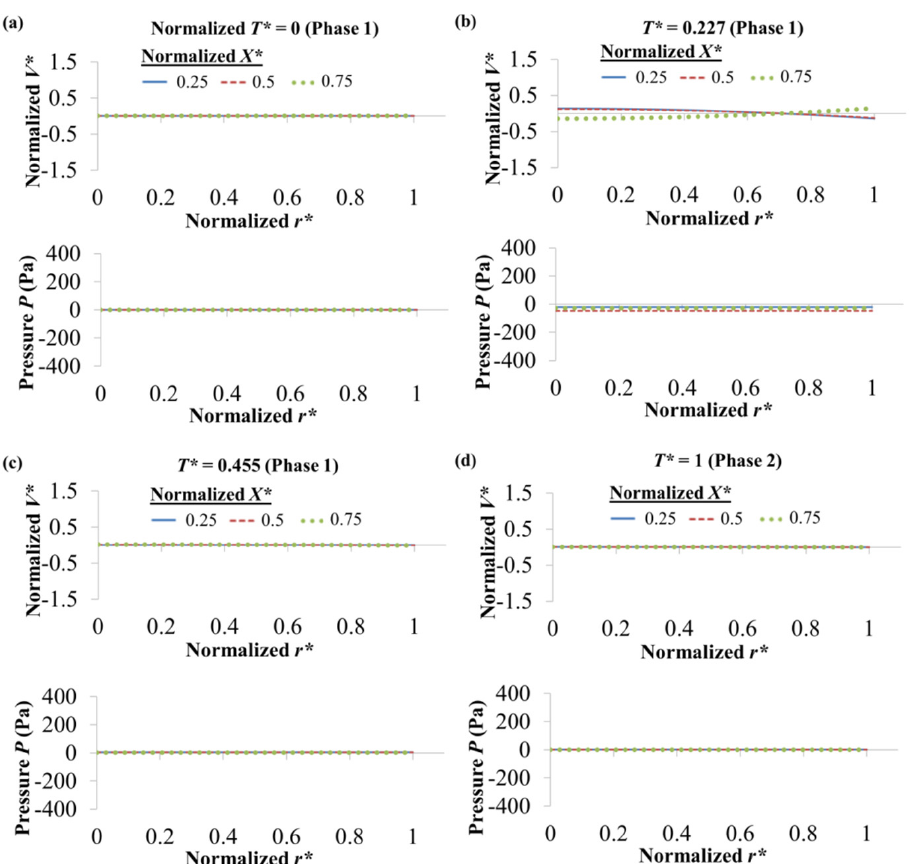
Figure 8. Numerically simulated normalized velocity V* and pressure P along normalized radial r* for normalized X* = 0.25, 0.5 and 0.75 of 0.5 mM NaHCO 3 → 0.5 mM NaCl (arrow indicates EOF direction) in ( a ) Phase 1 T* = 0, ( b ) Phase 1 T* = 0.227, ( c ) Phase 1 T* = 0.455 and ( d ) Phase 2 T* = 1. Normalized V* = ( V − V Avg )/ V Avg . Average velocity V Avg = Q / A L = Q /( π R 2 ), where Q is flow rate obtained by integrating radial velocity over microchannel cross sectional area A L , and R is channel radius. Normalized r * = r / R . Normalized time T* = T / T SSNaCl → NaHCO3 , where T SSNaCl → NaHCO3 is time to reach steady-state current for NaCl → NaHCO 3 . Normalized X*= X / L , where X is axial coordinate and L channel length.